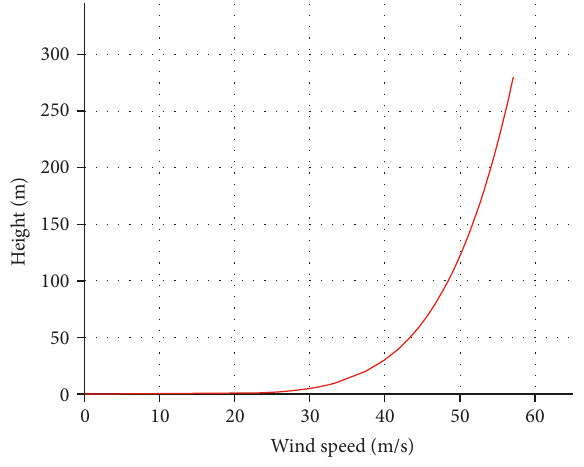
Figure 3: Average wind profile